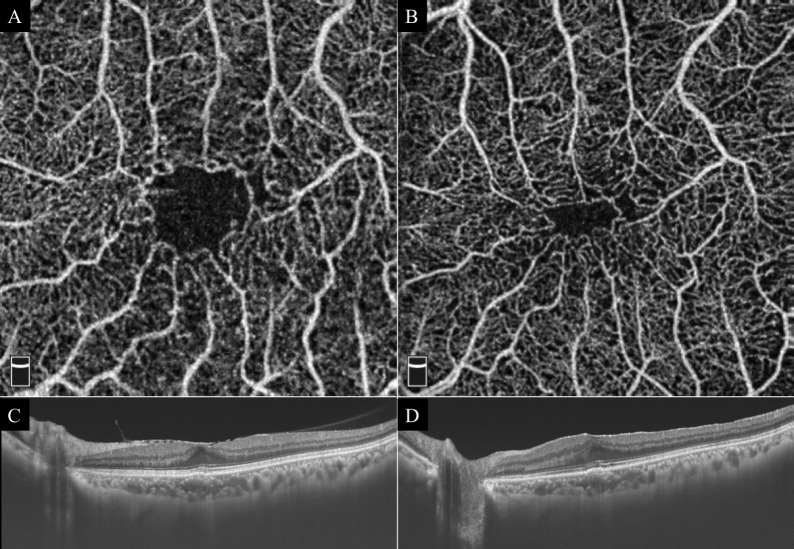
Representative case with a reduction of the FAZ and an increase in the CFT after vitrectomy with ILM peeling.A: Superficial OCTA image before vitrectomy. Area of FAZ is 0.426 mm2. B: Superficial OCTA image after vitrectomy. Area of FAZ is 0.119 mm2. C: Cross-sectional OCT image before vitrectomy. CFT is 280 μm. D: Cross-sectional OCT image after vitrectomy. CFT is 335 μm.